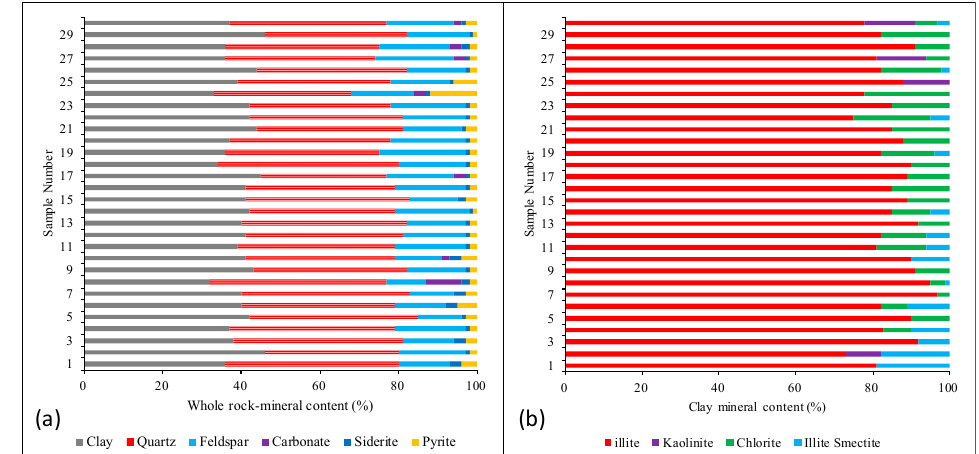
Figure 9. ( a ) The total rock mineral composition of the Xinkailing shale in Wuning; ( b ) the clay mineral composition of the Xinkailing shale.